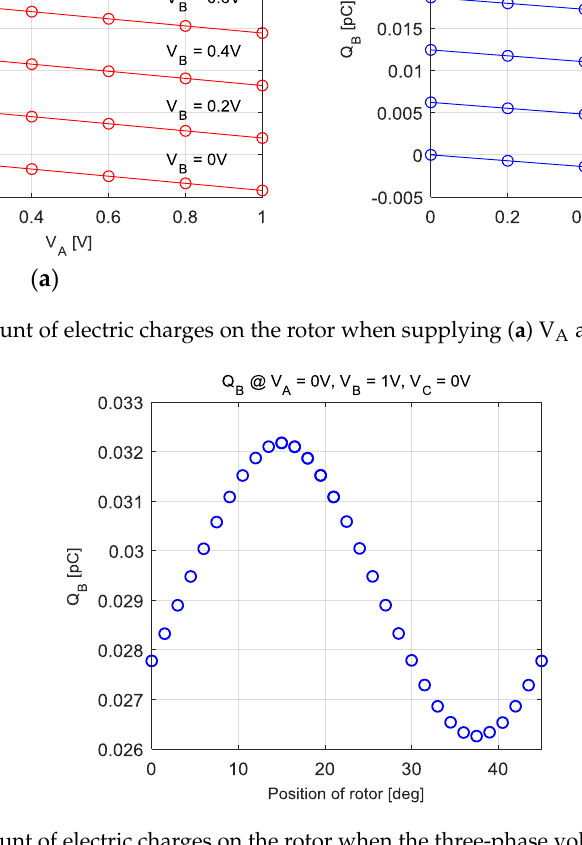
Figure 11. The amount of electric charges on the rotor when the three-phase voltage is supplied with a fixed voltage.